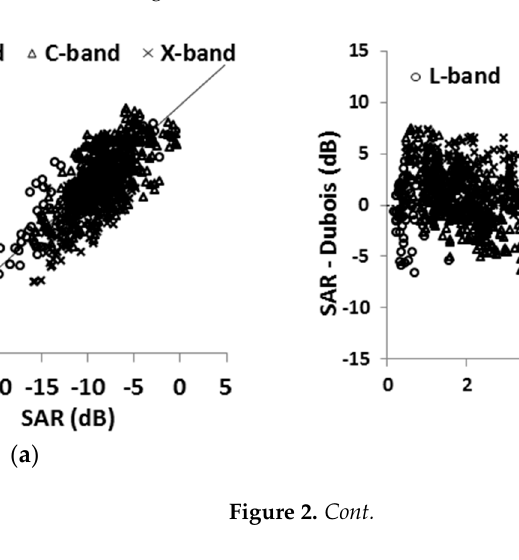
Figure 1. Comparison between backscattering coefficient values obtained from SAR images and those estimated from the Dubois model at HH polarization. ( a ) Dubois model simulations vs. SAR data; ( b ) difference between SAR signal and the Dubois model vs. soil roughness ( kHrms ); ( c ) difference between SAR signal and the Dubois model vs. soil moisture ( mv ); ( d ) difference between SAR signal and Dubois model vs. incidence angle.